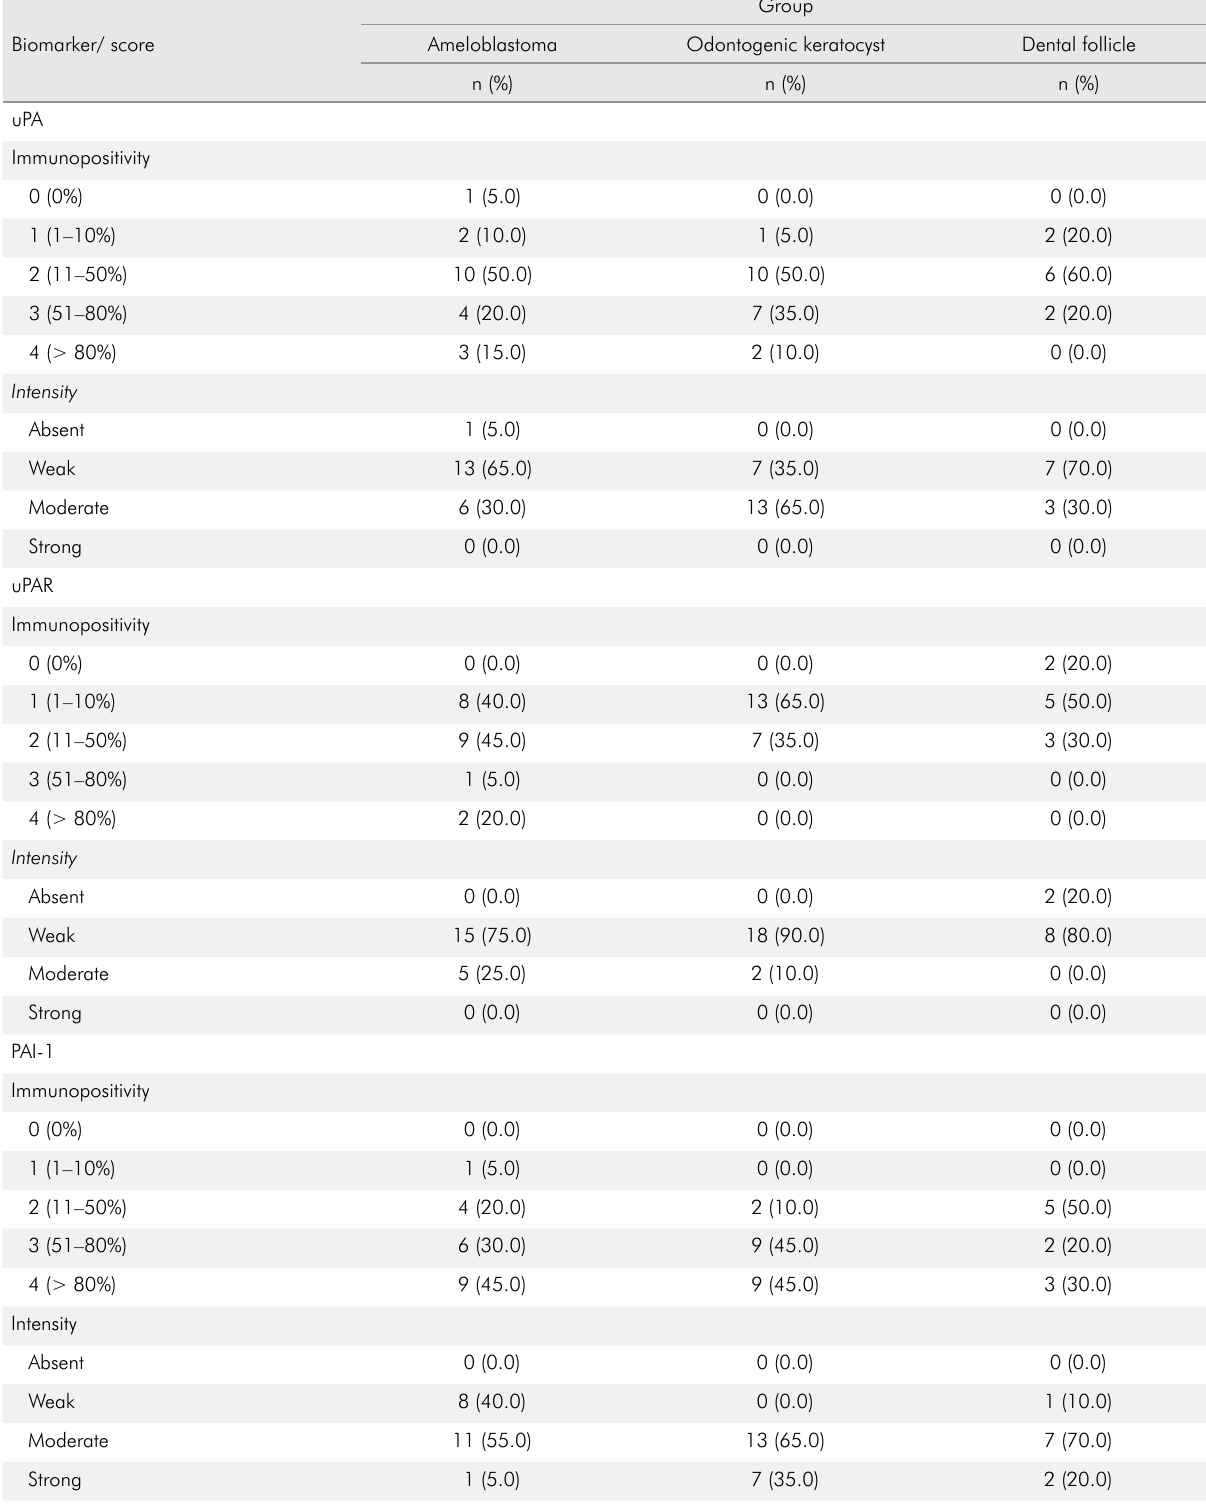
Table 4. Distribution of ameloblastomas, odontogenic keratocysts and dental follicles according to the connective tissue scores of immunopositivity and intensity for uPA, uPAR and